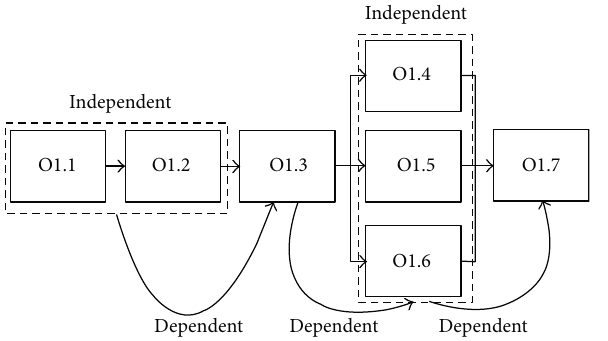
Figure 3: Relations among approach